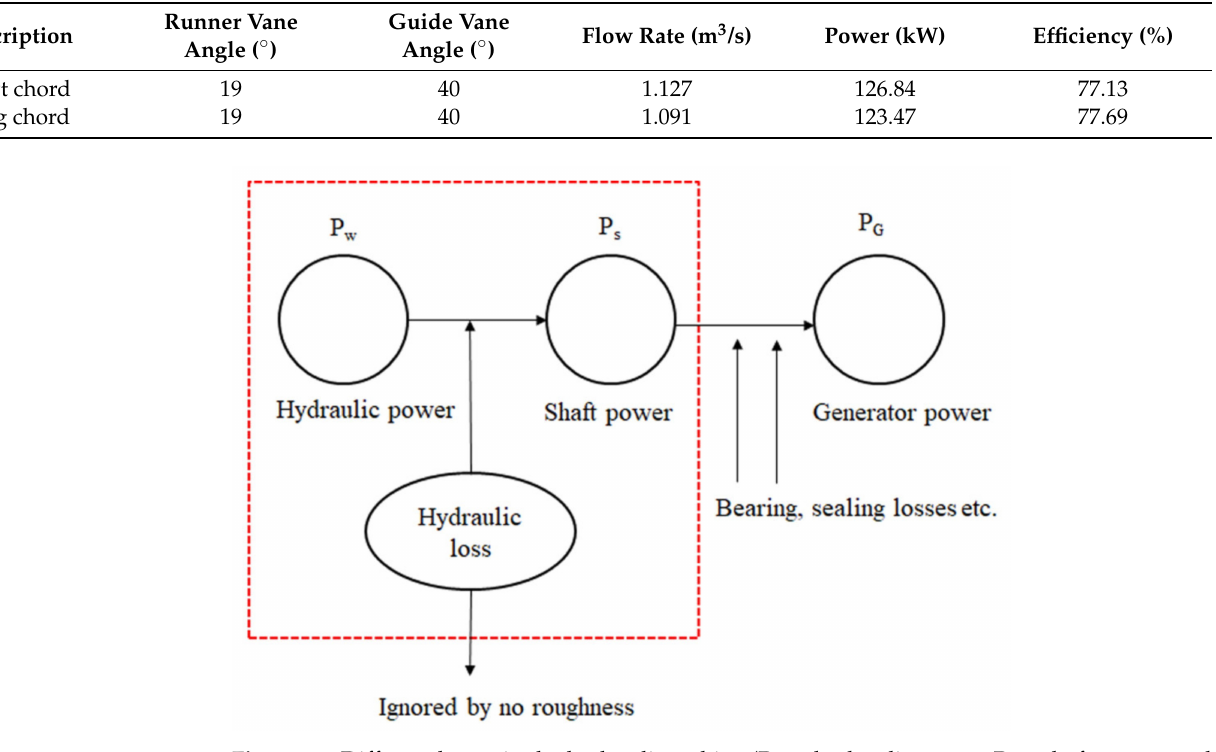
Figure 11. Different losses in the hydraulic turbine (P w = hydraulic power, P s = shaft power, and P G = generator